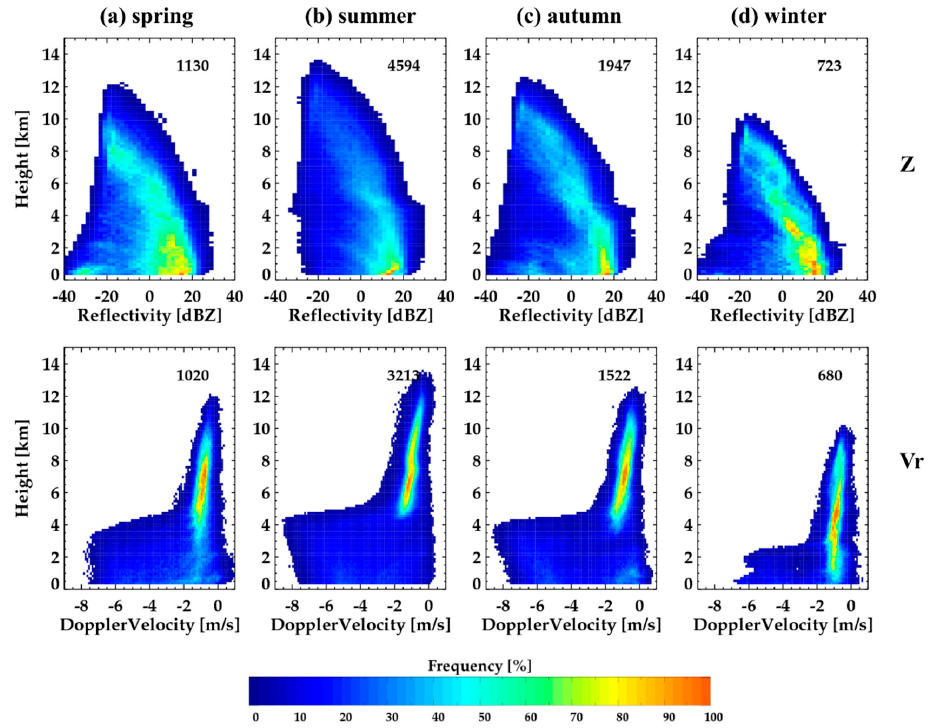
Figure 16 . CFADs of (upper) reflectivity and (lower) Doppler radial velocity for RainDP with seasons. ( a ) Spring, ( b ) summer, ( c ) autumn, and ( d )